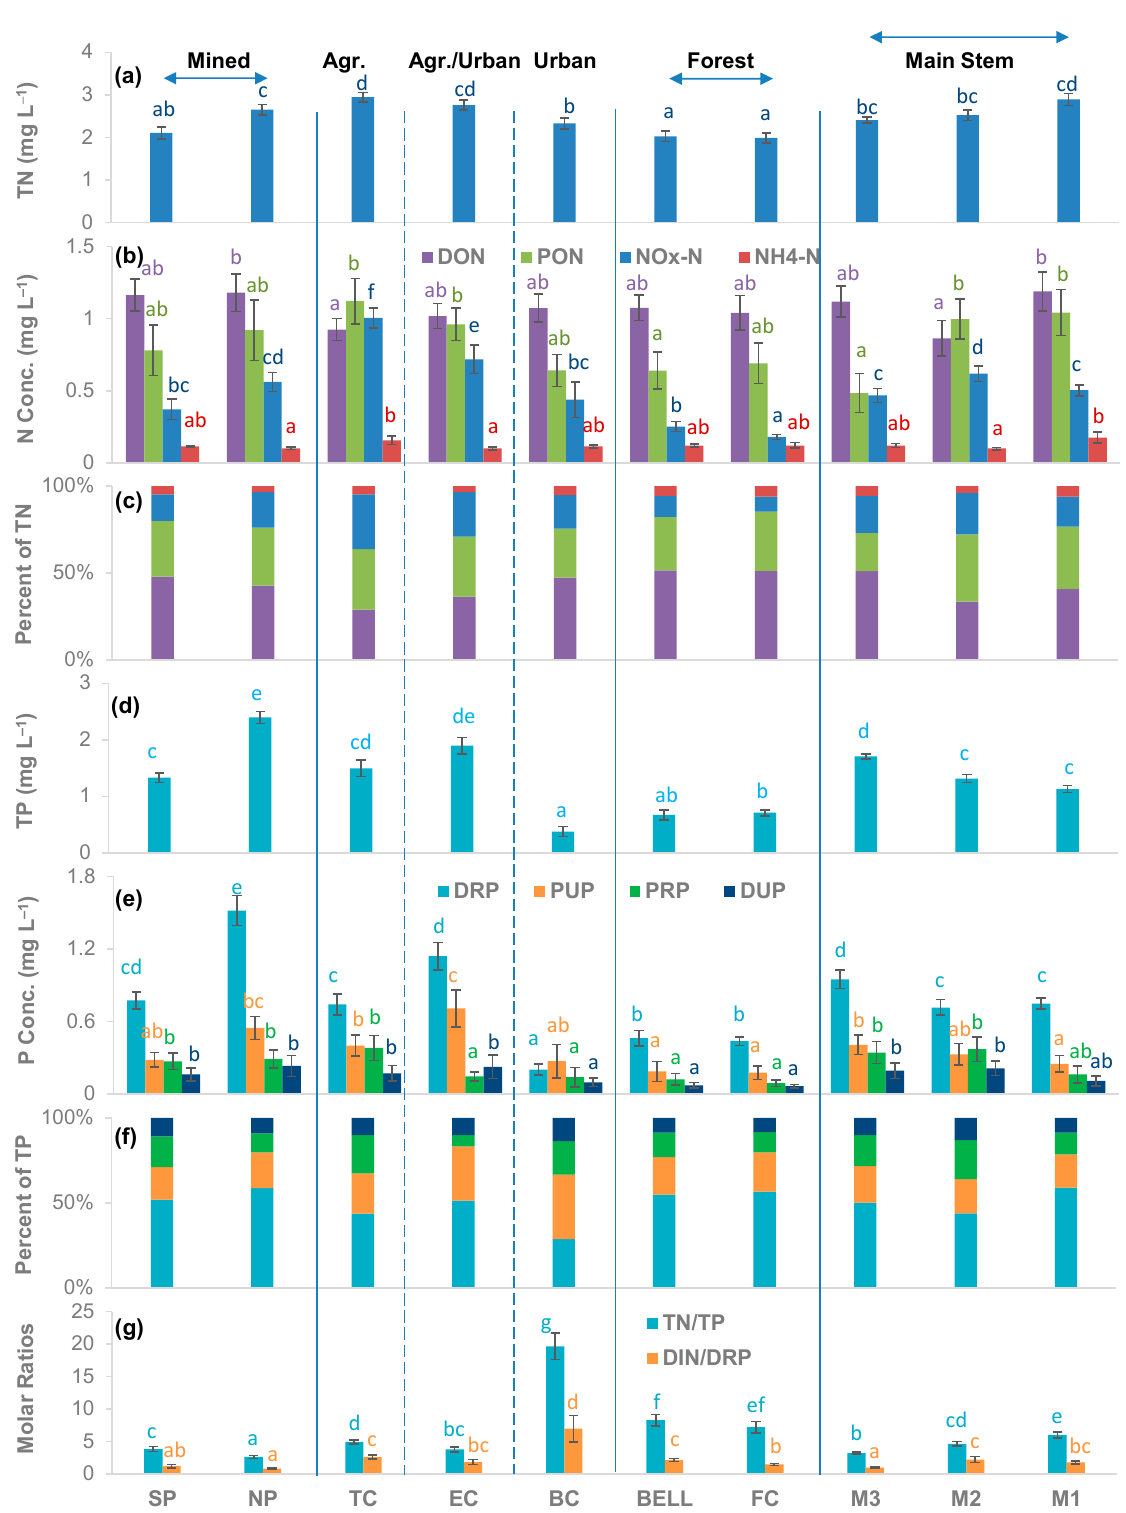
Figure 5. Changes in ( a ) concentrations of total N, ( b ) concentrations of N forms, ( c ) proportion of N forms, ( d ) concentrations of total P, ( e ) concentrations of P forms, ( f ) proportion of P forms, and ( g ) molar N to P ratios across a land-use gradient in the Alafia River. Stations marked by different letters are significantly different at p < 0.05. NP: North Prong; SP: South Prong; TC: Turkey Creek; EC: English Creek; BC: Buckhorn Creek; FC: Fishhawk Creek. DON: Dissolved organic N; PON: Particulate organic N; DRP: dissolved reactive P; PRP: particulate reactive P; DOP: dissolved organic P; PUP: particulate unreactive